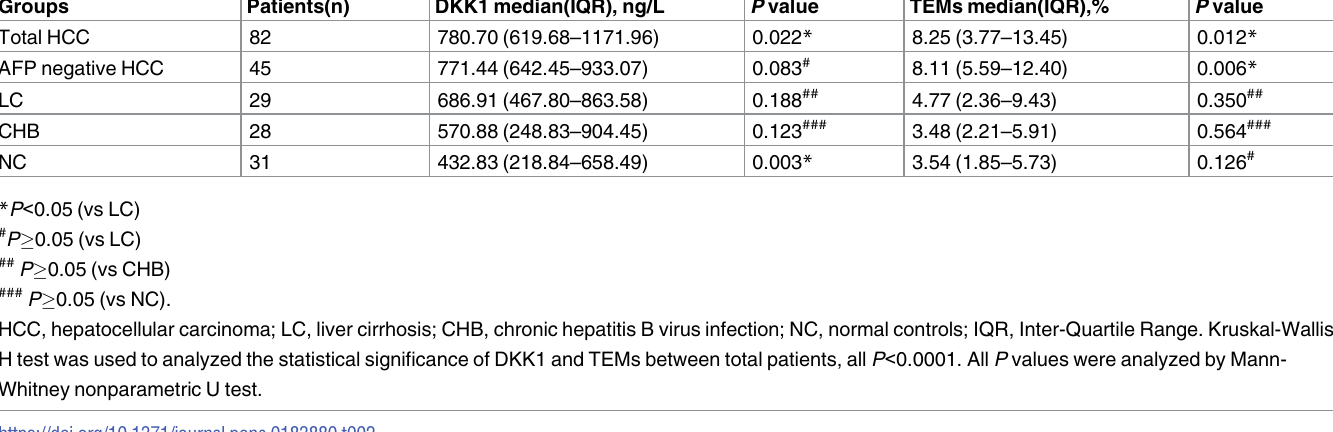
Table 2. Plasma DKK1 level and the percentage of TEMs in different groups.